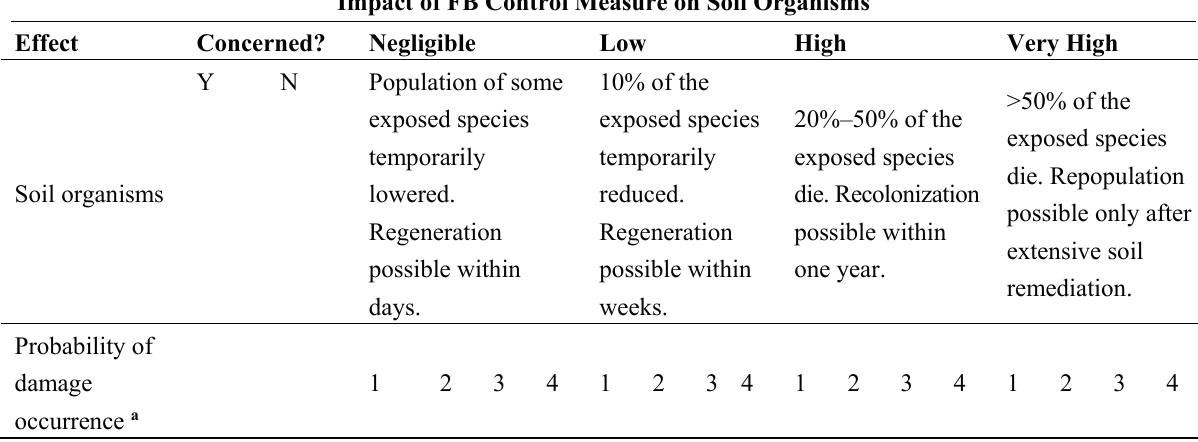
Table 2. Example of the assessment of the impact of the fire blight (FB) control measure on soil